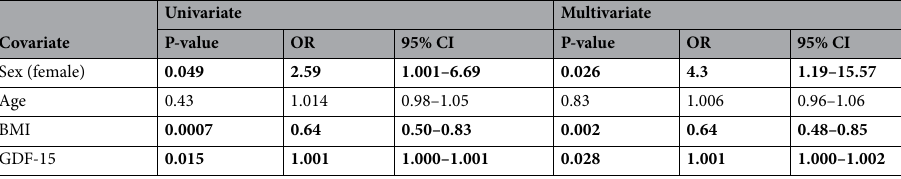
Table 4. Factors associated with a low SMI among CD patients. Data were analyzed using a univariate analysis and multivariate analysis and adjusted using a logistic regression analysis. BMI body mass index, CD Crohn’s disease, GDF-15 growth differentiation factor-15, OR odds ratio, CI confidence interval, SMI skeletal muscle mass index. Significant values are in